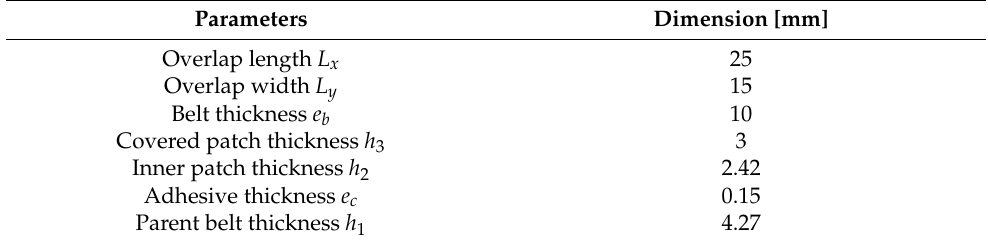
Table 2. Geometric properties of the repaired belt.